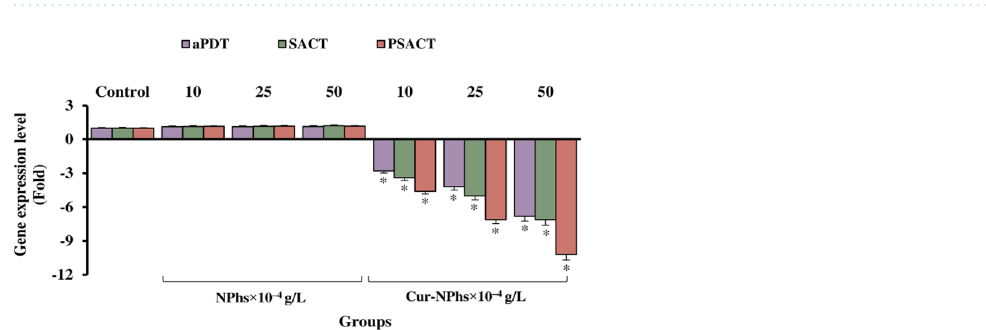
Figure 10. Gene expression levels of rcpA following different treatments. Significant differences according to the control, *P <